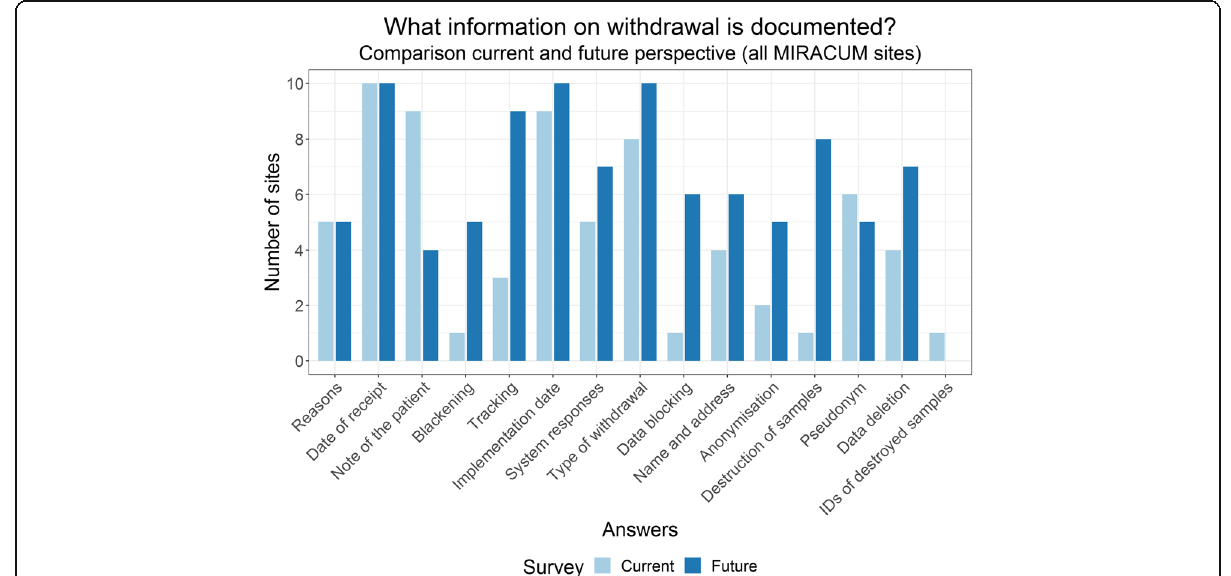
Fig. 2 What information on withdrawal is documented?. Frequency distribution which information for withdrawals are documented currently and in future perspective. (Blackening: making certain content